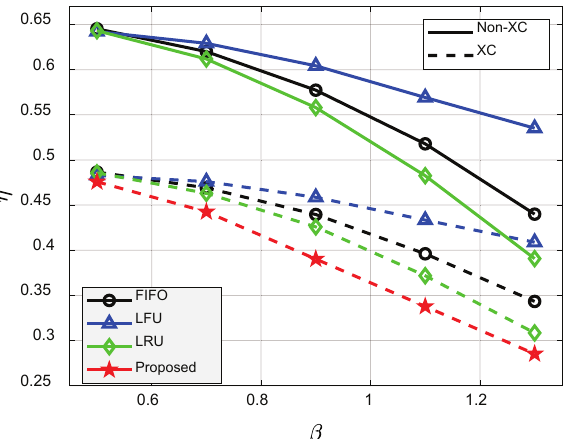
Figure 10. Average number of required transmissions for various β ’s. p = 0.001, ρ = 0.5, V = 100, N = 50, C = 20, and K =